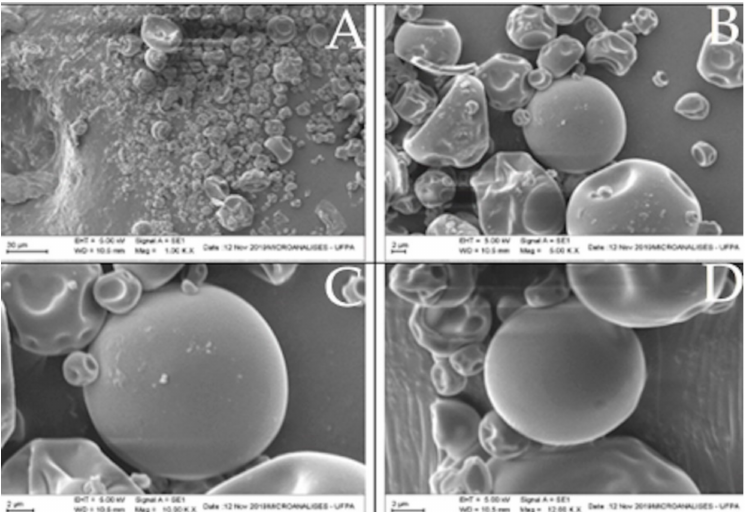
Figure 4. Microparticle photomicrographs: ( A ) (1000- × magnitude), ( B ) (5000- × magnitude), ( C ) (10,000- × magnitude) and ( D ) (12,000- ×